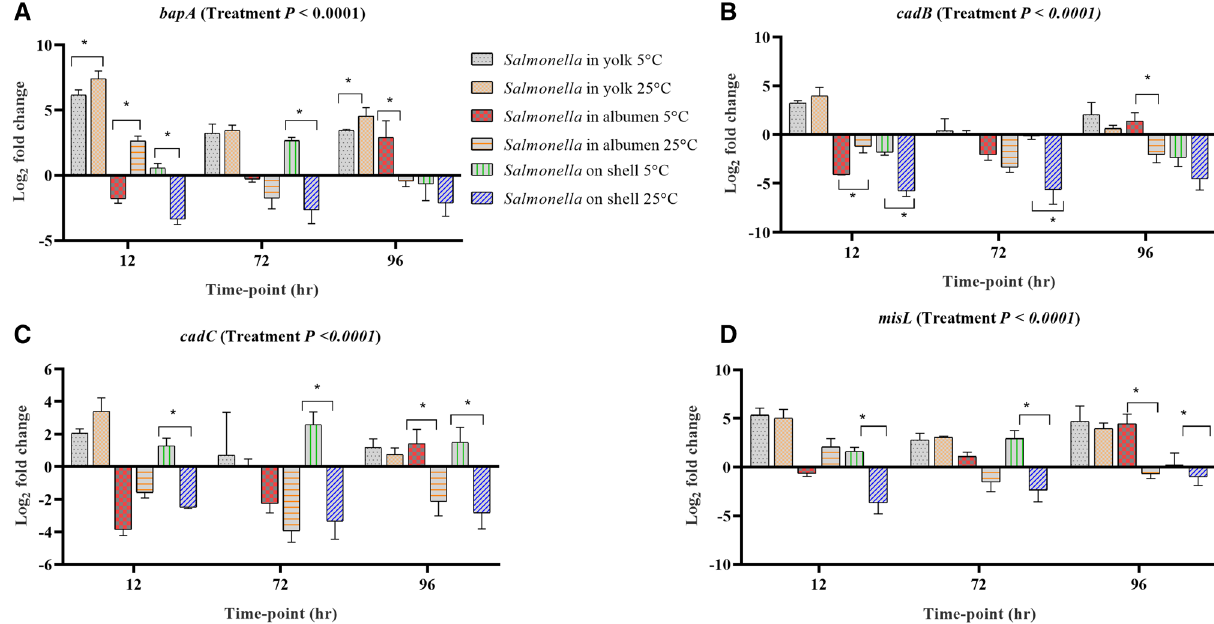
Figure 3. Regulation of genes in Salmonella Typhimurium inoculated into yolk, albumen and eggshell stored at 5 °C and 25 °C. Relative expression (log 2 fold change ± S.E.) of ( A ) bapA ; ( B ) cadB ; ( C ) cadC and ( D ) misL at 12, 72 and 96 h of incubation time. Within each egg component and storage time-point, asterisks across the bars show significant differences (P <